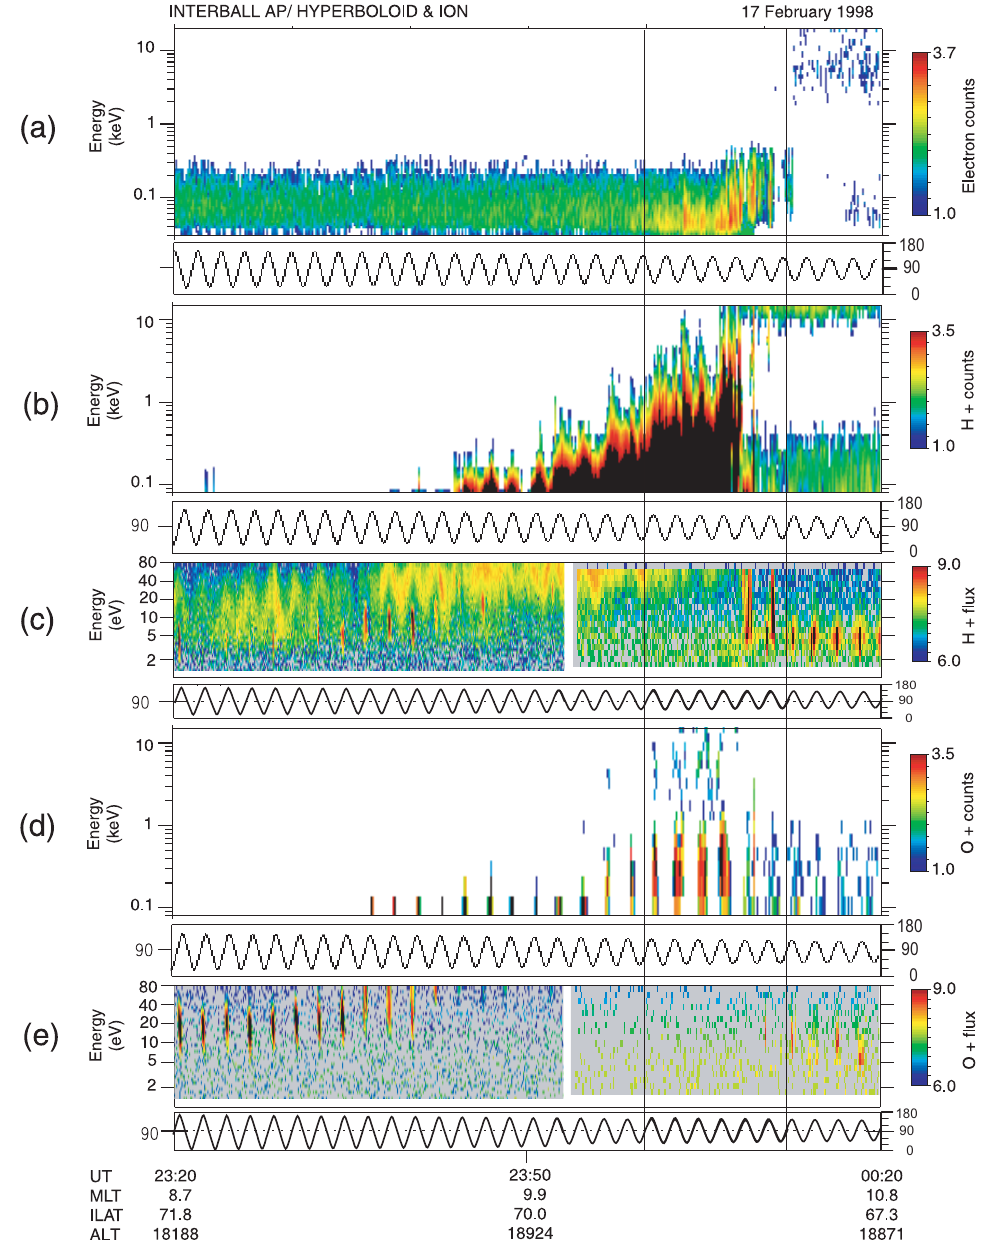
Fig. 2. Overview of a transverse ion heating event on 17 February 1998, between 23:20 and 00:20 UT. The format is the same as for Fig. 1.